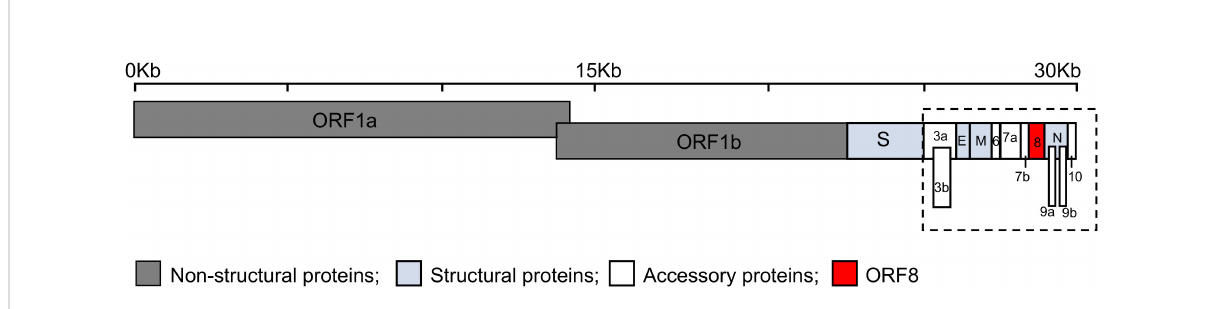
FIGURE 1 Schematic representation of the genomic organization of SARS-CoV-2. The SARS-CoV-2 genome, ~30 kilobases (Kb), encodes fi fteen open reading frames (ORFs) for non-structural (dark grey: ORF1a and ORF1b), structural (light blue: spike (S), envelope (E), membrane (M) and nucleocapsid (N)), and accessory proteins (white: ORF3a, 3b, 6, 7a, 7b, 9a, 9b, and 10) with ORF8 shown in red. The accessory proteins (dashed box) are interspersed among or within the genes encoding structural